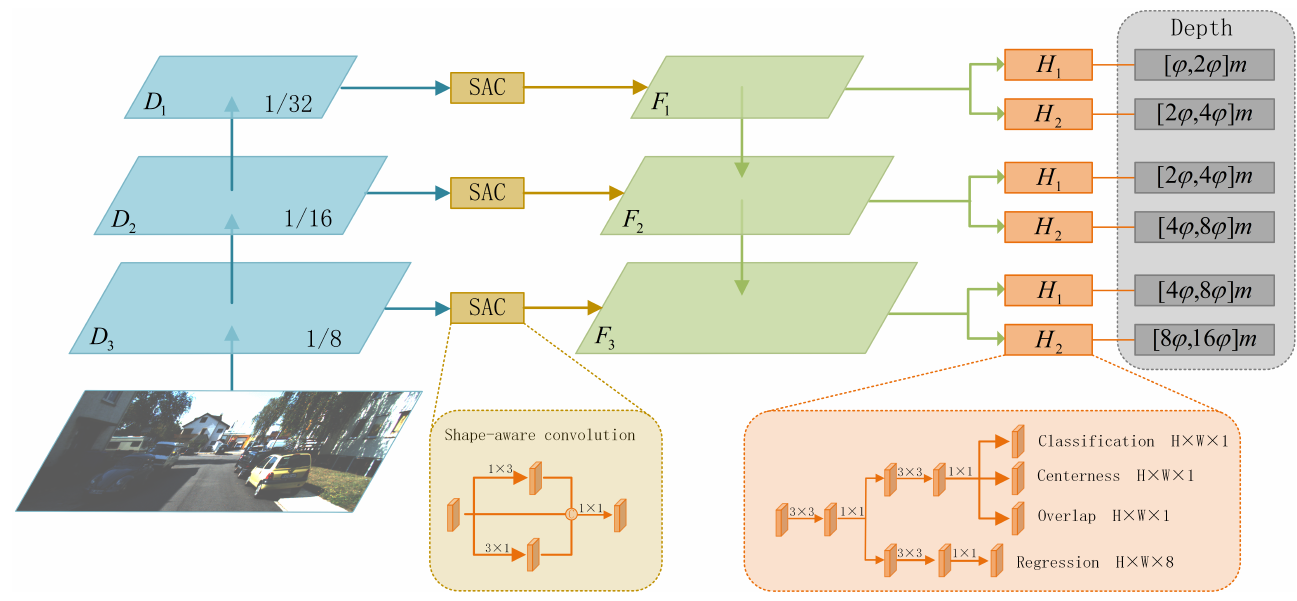
Figure 1. Overview of our proposed